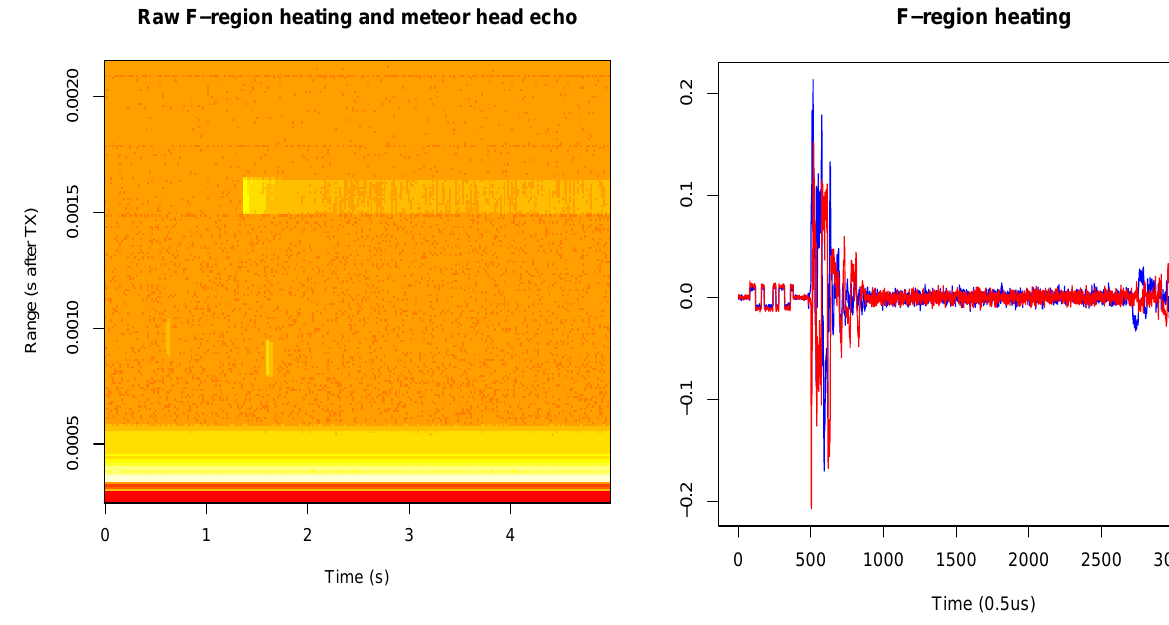
Fig. 3. Example transmission and echo from a point-like heating effect in the F-region. In this case from the EISCAT UHF signal. The transmitted signal is in the beginning of the signal, followed by ground clutter and the ionospheric echo. At around 1500 µ s one can see the F-region heating related echo. The time on the x-axis is in samples which are 0 . 5 µ s long. The red and blue represent real and complex parts of the baseband